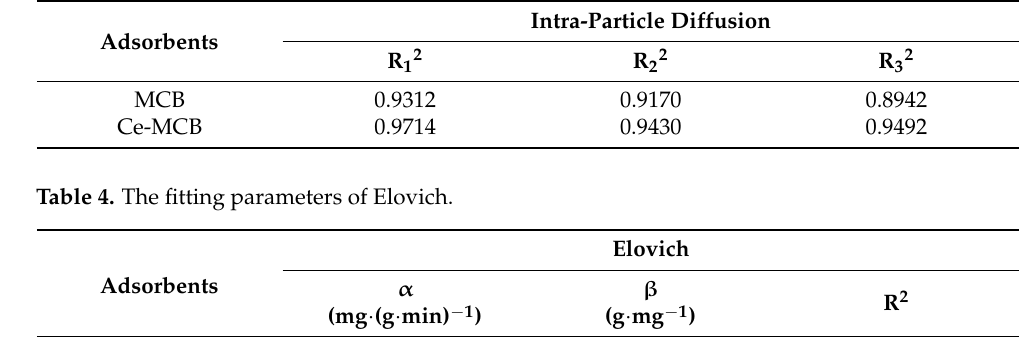
Figure 13. Elovich model of magnetic biochar for Pb 2+.